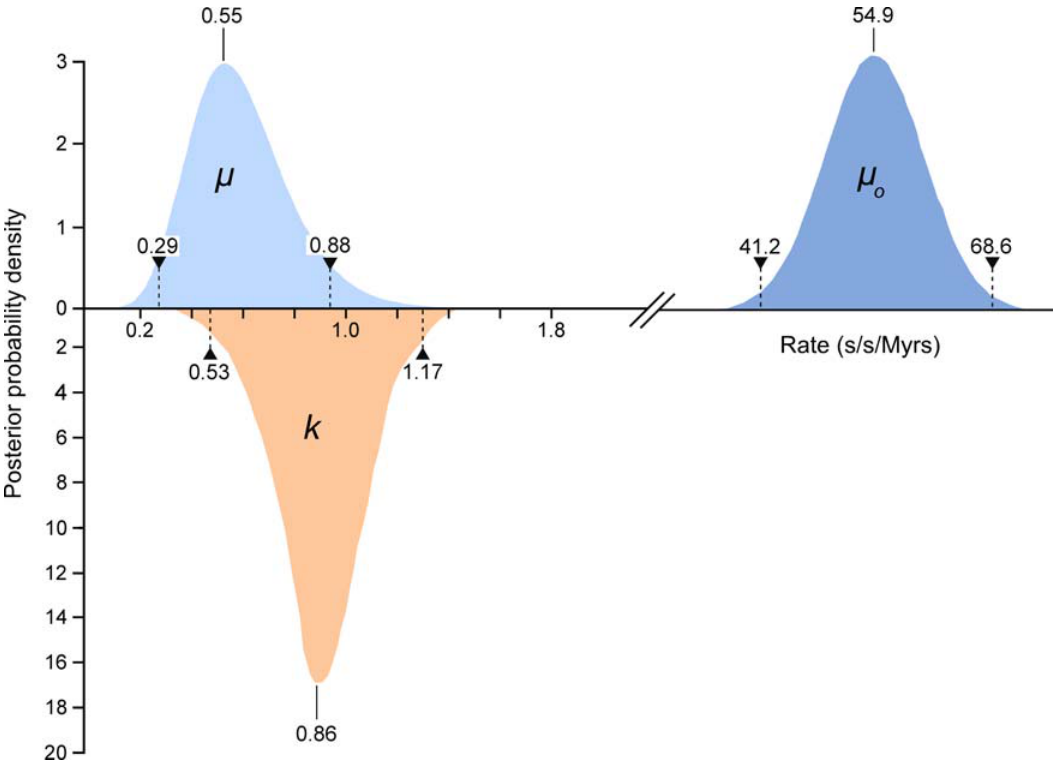
Figure 2. The estimates of the frequency of observed heteroplasmies ( m o ) with the mean and 95% confidence intervals are shown. The distribution, mode and confidence intervals of the mutation rate ( m ) derived from modeling the inter-generational persistence of the heteroplasmies are also shown. The posterior probability densities of the evolutionary rate ( k ), estimated from 162 ancient penguin bones of known ages, are shown below the line. The median and 95% intervals are given.